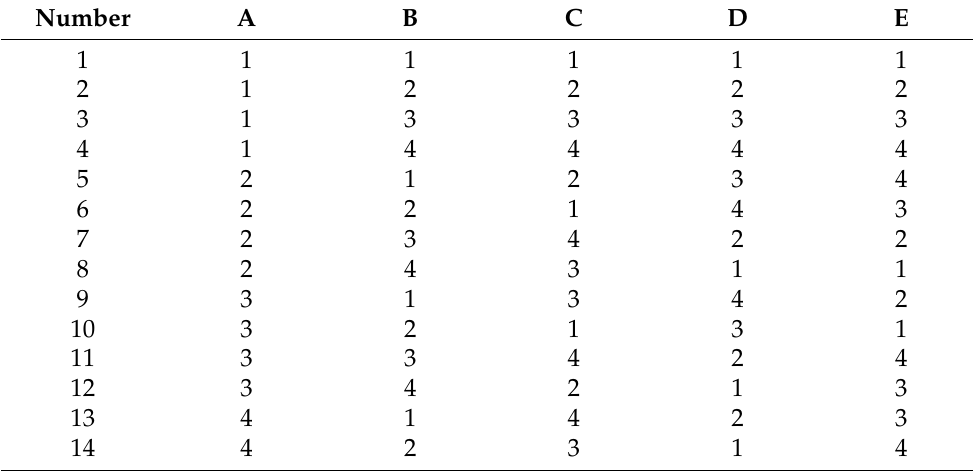
Table 2. Optimization scheme of orthogonal